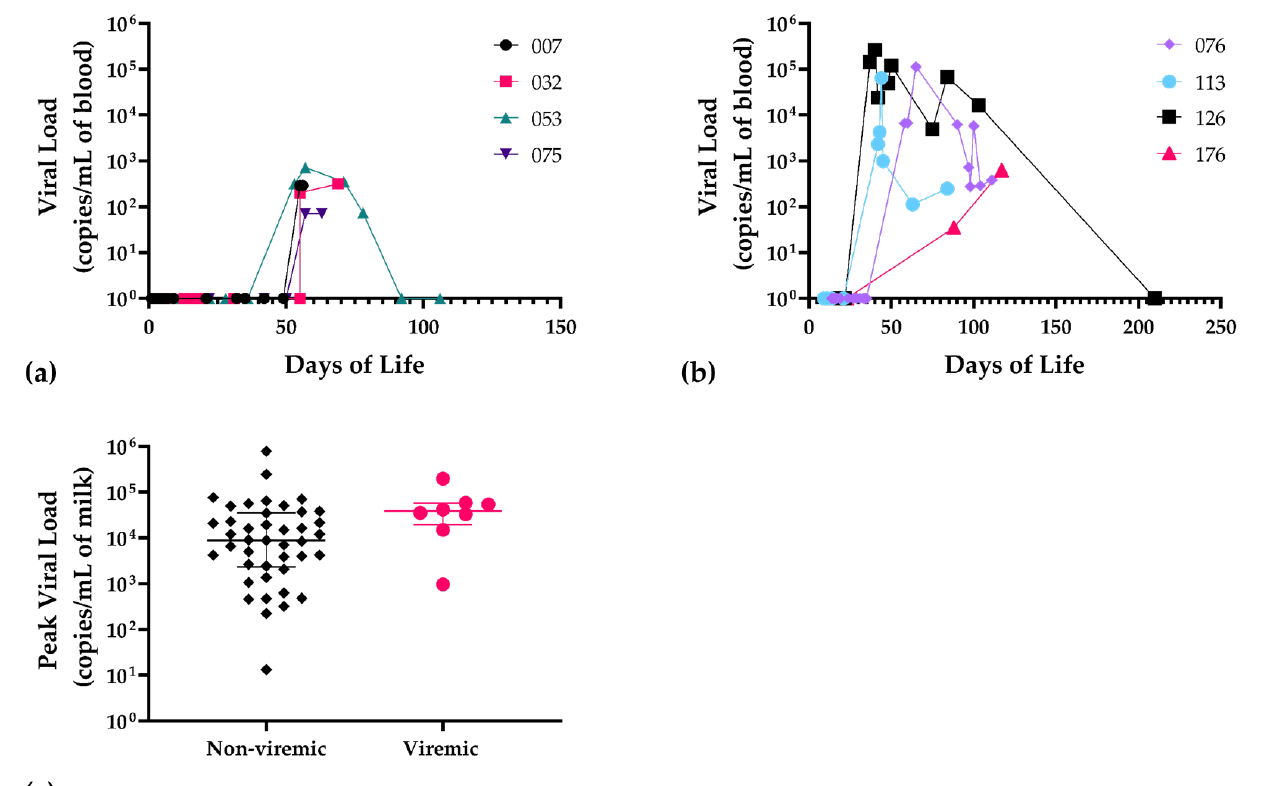
Figure 3. Patterns of DNAemia in infants and corresponding maternal breast milk viral load in VLBW infants acquiring infection. ( a ) Temporal sequence of DNAemia showing viral blood load in infants 007, 032, 053, 075, and ( b ) infants 076, 113, 126, and 176; ( c ) viral load in maternal breast milk samples corresponding to the remaining 50 exposed, non-viremic infants (black diamond symbols) compared to viremic infants ( n = 8; red circles), p = 0.05, Mann – Whitney. For statistical comparisons, negative samples were assigned a value of 1 copy/mL of blood.